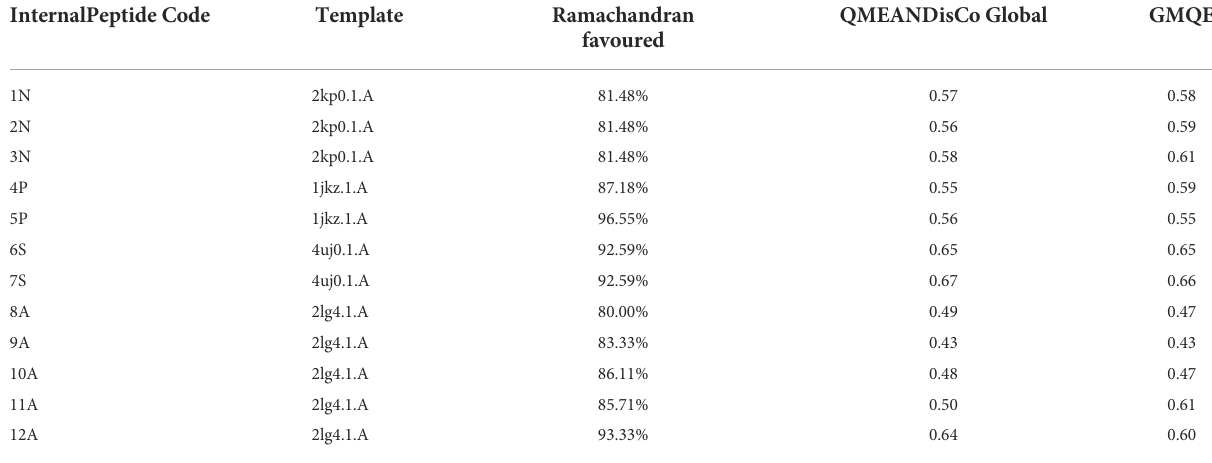
Access codes with symbol “ / ” belong to the REEFGENOMICS, “ * ” NCBI, “ _ ” OIST Marine Genomics Unit, or “ + ” CassiopeaBase database. The values of the percentage (%) identity between the peptides obtained in Cnidaria and the templates used for structural modeling are presented. TABLE 2 Assessment of models ’ quality. InternalPeptide Code